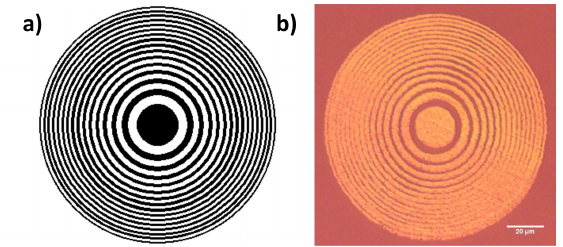
ring number: 32, numerical aperture (NA): 0.7, 305 × 305 pixels image. b) Transmission optical microscope image of the laser written metalens onto silicon based metalens templates. The scale bar is 20 µ